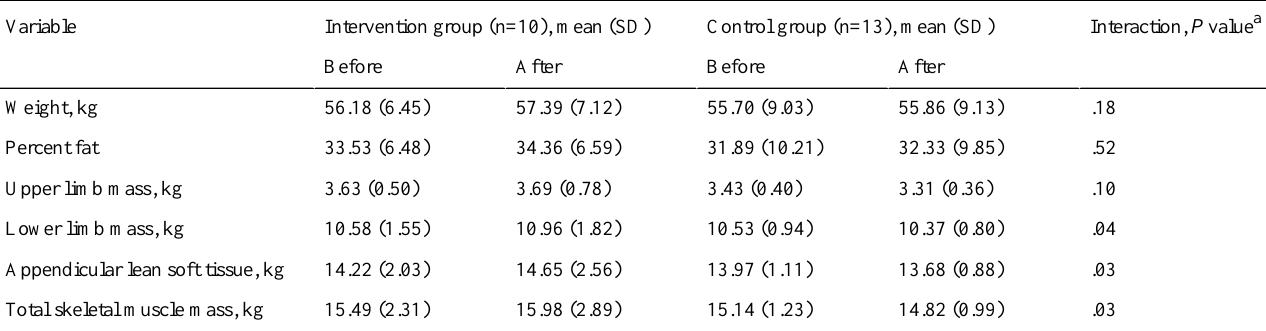
Table 2. Changes in body composition. Before and After refer to measurements taken before and after the 12-week intervention period, respectively.